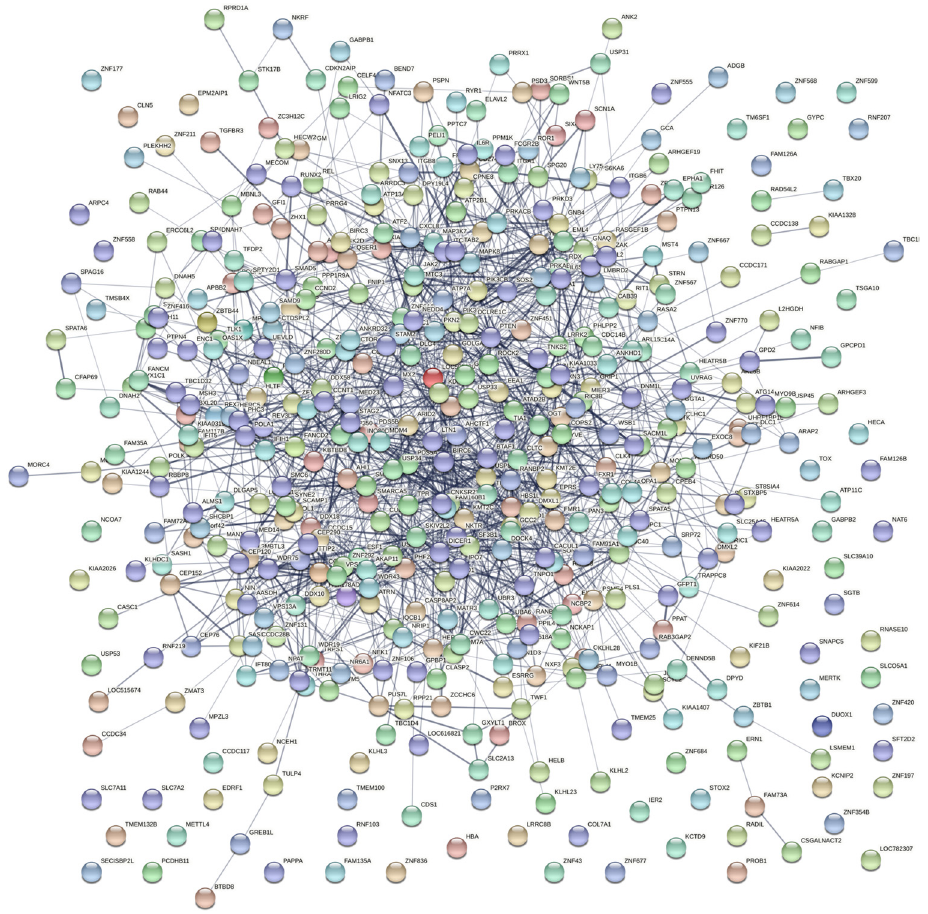
Figure 9. Protein interaction network diagram. Network nodes represent proteins: splice isoforms or posttranslational modifications are collapsed, i.e., each node represents all the proteins produced by a single, protein − coding gene locus; node color: colored nodes, query proteins and first shell of interactors; white nodes, second shell of interactors; node content: empty nodes, proteins of unknown 3D structure; filled nodes, some 3D structure is known or predicted; edges represent protein–protein associations; associations are meant to be specific and meaningful, i.e., proteins jointly contribute to a shared function, but this does not necessarily mean they are physically binding to each other.